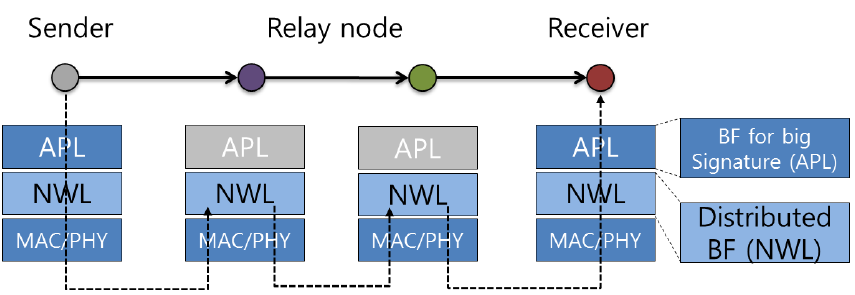
Figure 4. Example of the proposed IDS